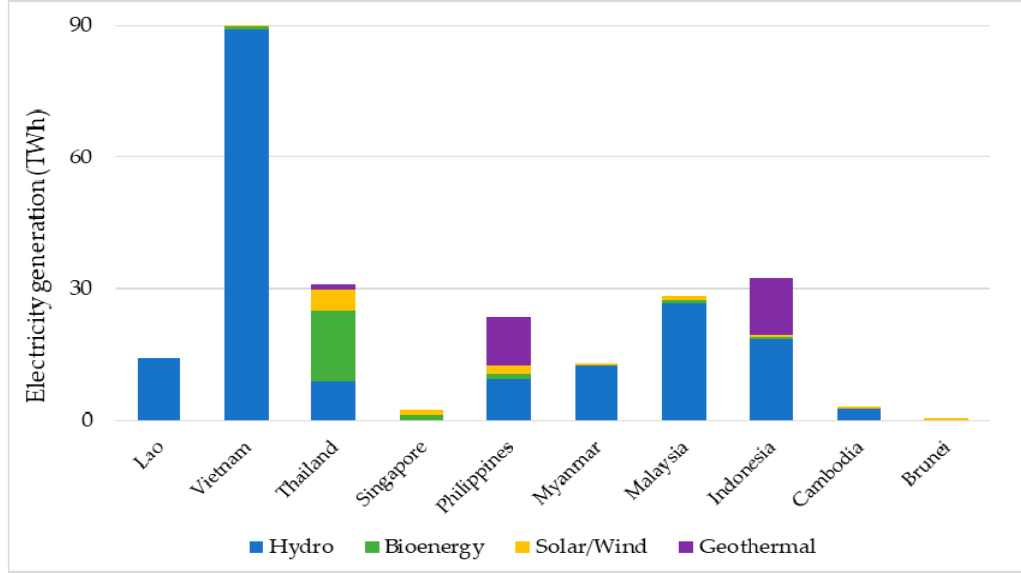
Figure 2. Electricity generation from renewables in Southeast Asia as of 2017.